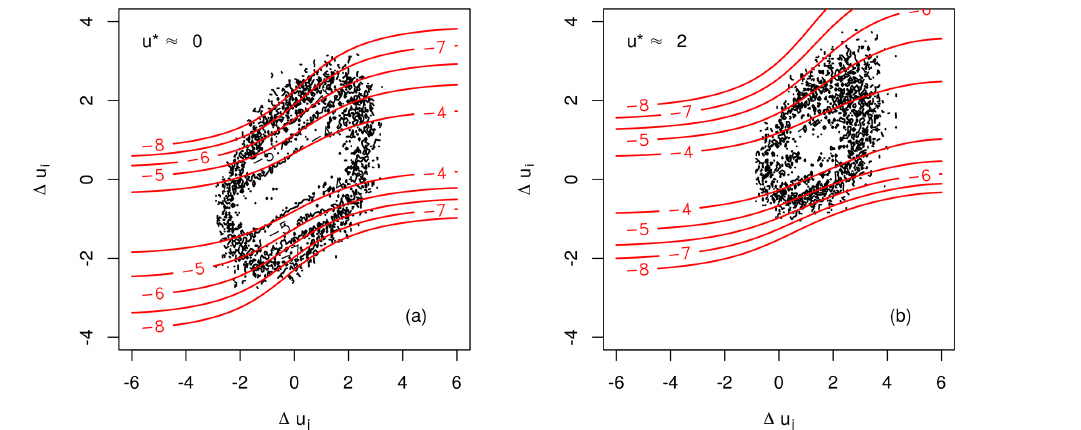
Figure 5. Isoline plots of a cpdf p ( (cid:49)u i ,τ i | (cid:49)u j ,τ j ; u ∗ ) estimated from the data (black) and from the numerical solution of the FPE (red) for τ i = 1 . 6s and τ j = 3 . 2s and for u ∗ ≈ 0 and u ∗ ≈ 2.